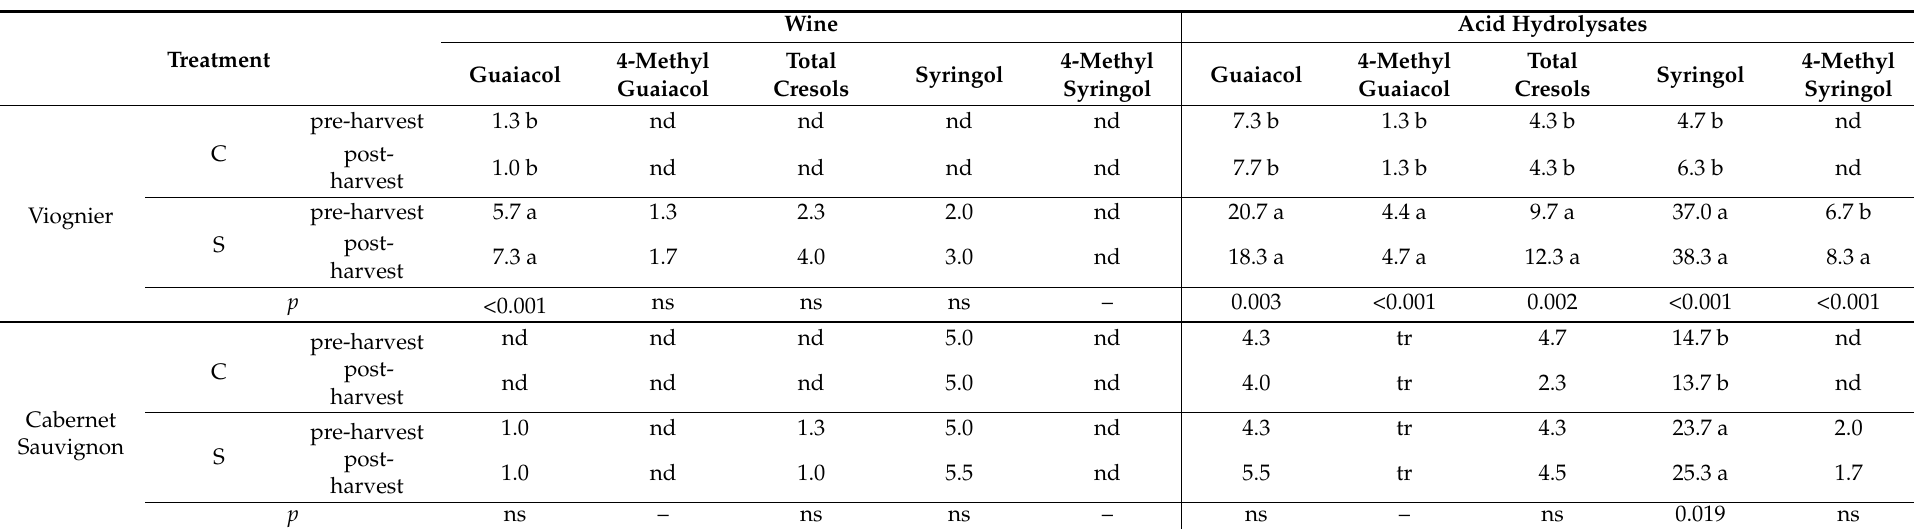
Table 2. Concentrations of volatile phenols ( µ g/L) in wines (and acid hydrolysates of wine) made from control (C) and smoke-exposed (S) grapes.